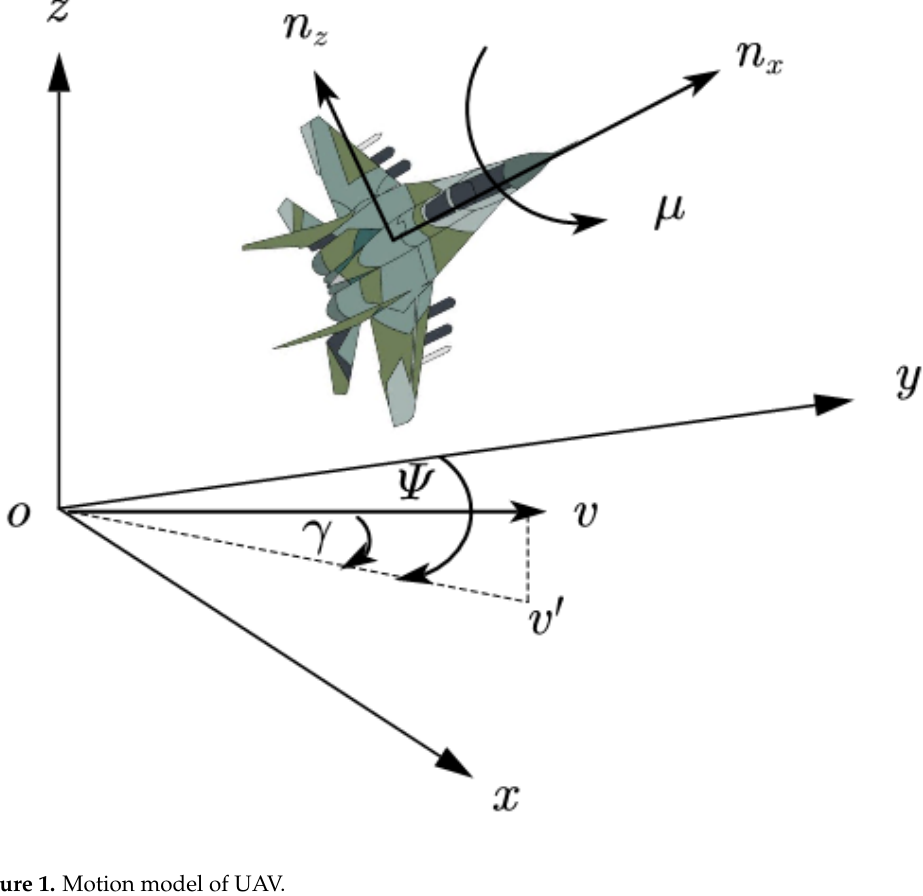
Figure 1. Motion model of